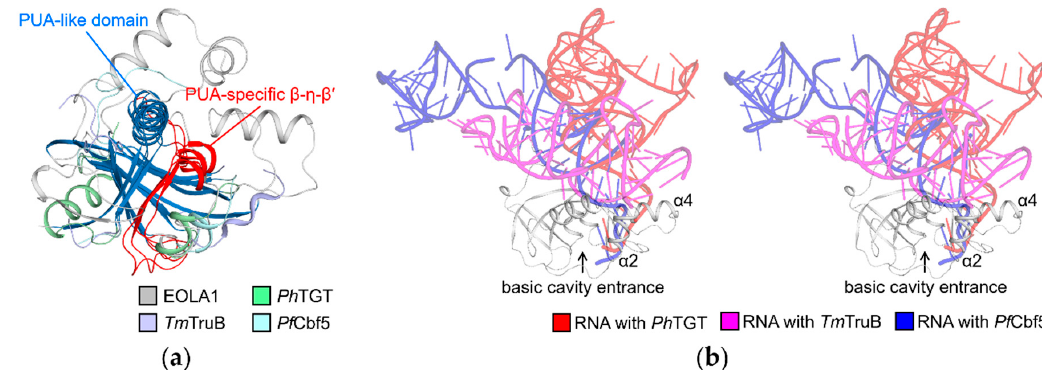
Figure 3. Structural comparison between EOLA1 and pseudouridine synthase and archaeosine transglycosylase (PUA) domain proteins. ( a ) Superimposition of EOLA1 with PUA domains in complex with RNAs. PUA domains of Pyrococcus horikoshii archaeosine tRNA-guanine transglycosylase ( Ph TGT, PDB ID: 1J2B), Thermotoga maritima tRNA pseudouridine synthase TruB ( Tm TruB, PDB ID: 1R3E), and Pyrococcus furiosus probable tRNA pseudouridine synthase B ( Pf Cbf5, PDB ID: 2HVY) are superimposed with EOLA1. Common topology structures shared by the four proteins are labeled as the PUA-like domain and colored in blue. The PUA-specific β - η - β′ that is conserved in PUA domains but not in EOLA1 are colored in red. The other parts of EOLA1, Ph TGT, Tm TruB, and Pf Cbf5 are colored in gray, pale green, light blue, and pale cyan, respectively. ( b ) Stereo-view of EOLA1 superimposed with RNA molecules complexed with PUA domains. RNA molecules complexed with Ph TGT, Tm TruB, and Pf Cbf5 are colored in red, magenta, and blue, respectively. The complexed PUA domains are not shown.